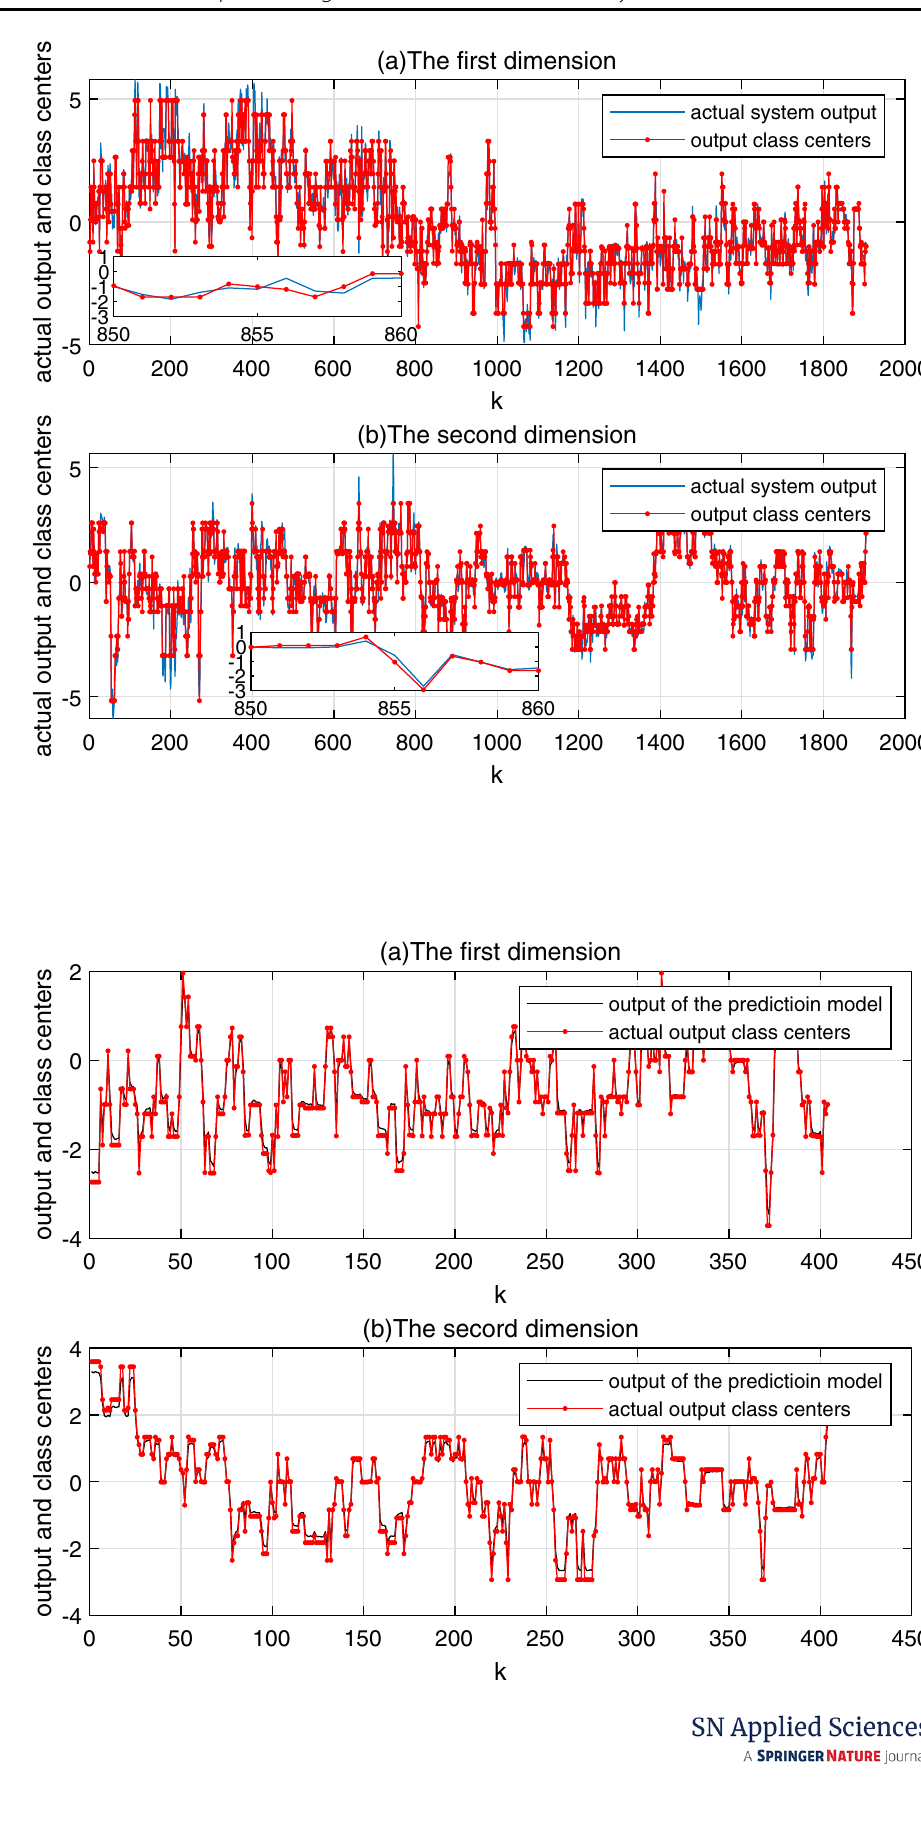
Fig. 5 Actual output data and measurement values of pattern class variables